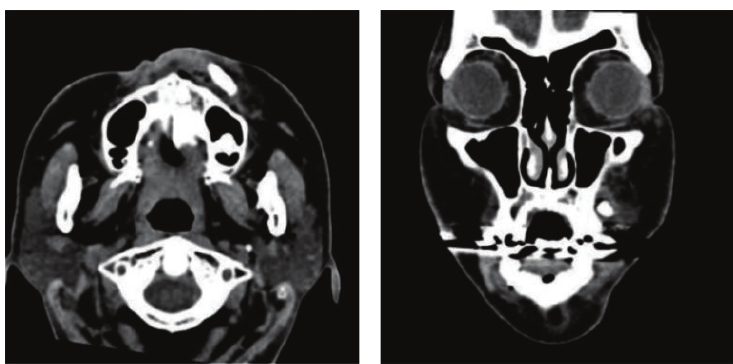
Figure 5: Coronal and axial CT showing embedded canine into soft tissue of the vestibule of the mouth.